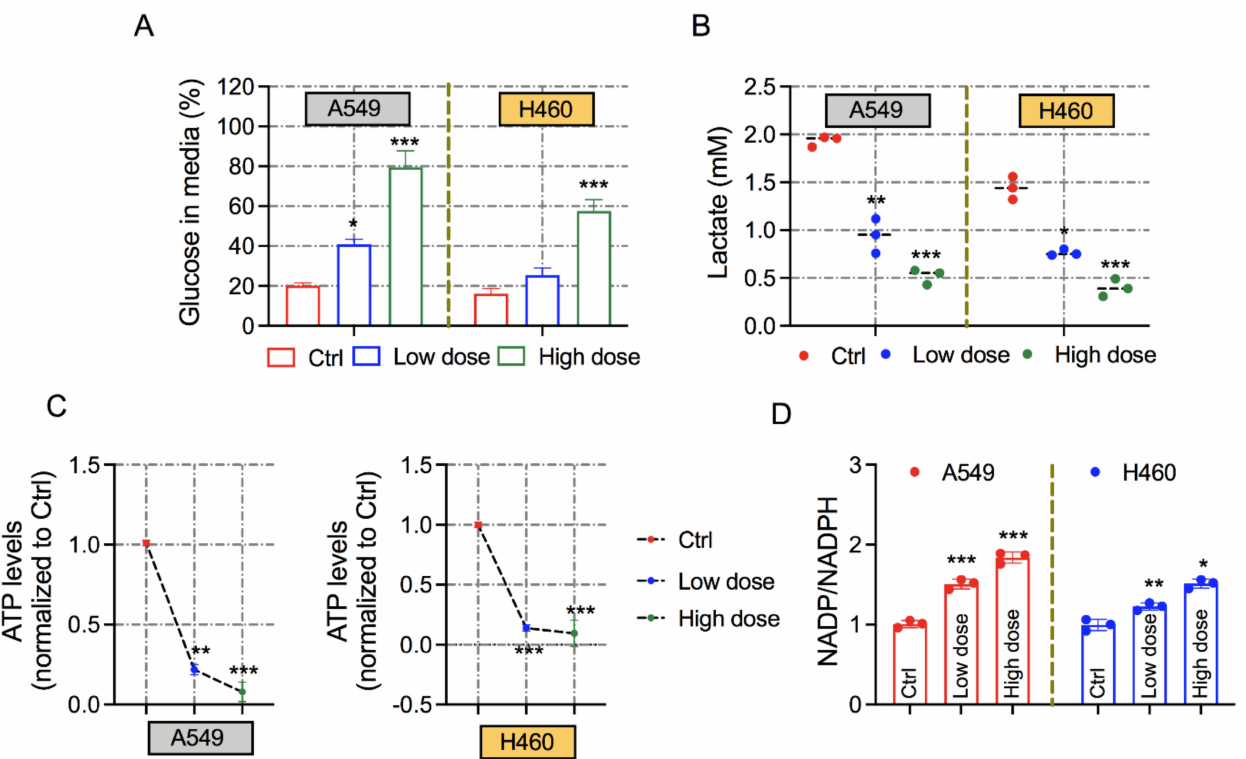
Figure 3. Treatment with 6-AN modulates metabolic indicators of lung cancer cells. ( A ) Glucose consumption was determined at low (10 µ M) and high (200 µ M) concentrations of 6-AN in A549 and H460 lung cancer cells. ( B ) Graph of lactate levels in A549 and H460 cancer cells under both conditions. ( C ) Measurement of cellular ATP levels in A549 and H460 cancer cells following treatment with low (10 µ M) and high (200 µ M) 6-AN treatments. ( D ) Analysis of the NADP+/NADPH ratio in A549 and H460 cancer cells after 48 h of 6-AN treatment at low and high doses. * p < 0.05; ** p < 0.01; *** p <